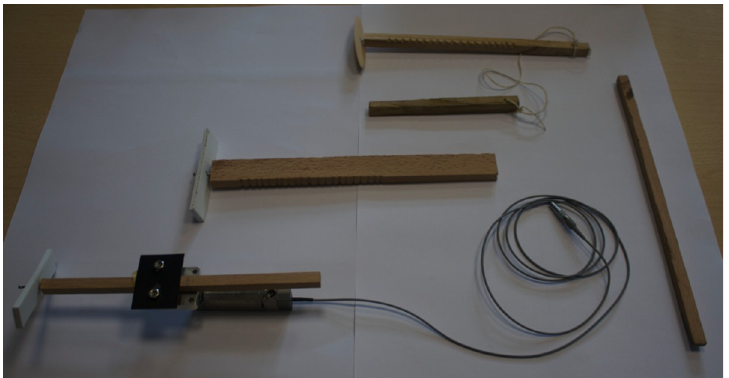
Fig 1. Some examples of Notched Stick. The typical appearance of the Notched Stick (NS): (from the top) a commercial one completely wood made; a NS with a rectangular stick and a plastic rotor without a microbearing; a NS mounted on a piezo, consisting of a square stick and a plastic rotor endowed with a